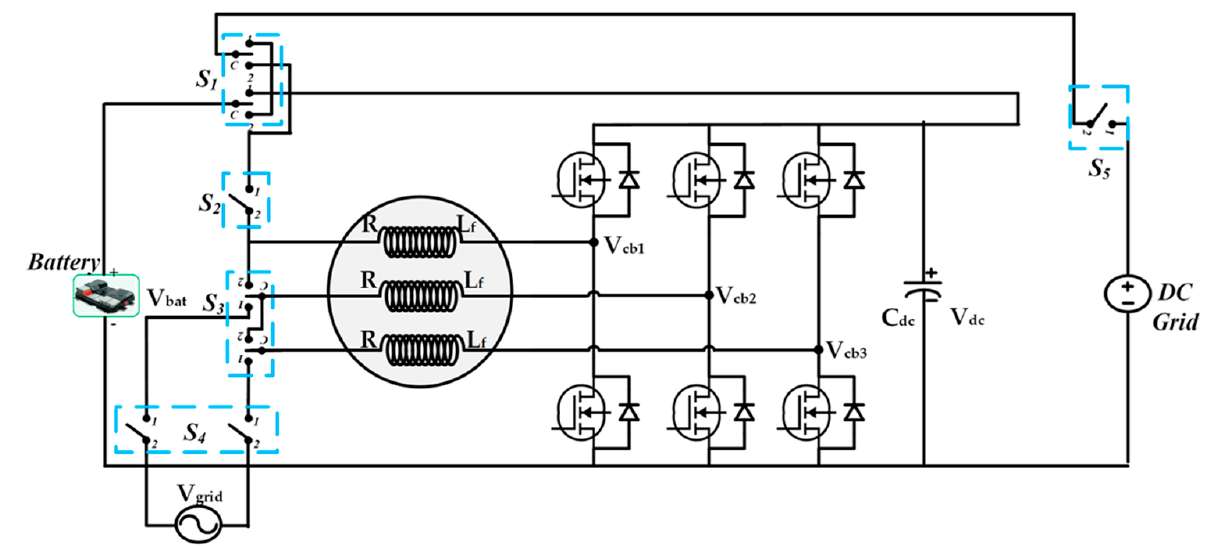
Figure 8. Induction motor drive integrated on − board charger with motor winding reconfiguration proposed by Khan et al. [66] in 2012 (iOBC4).